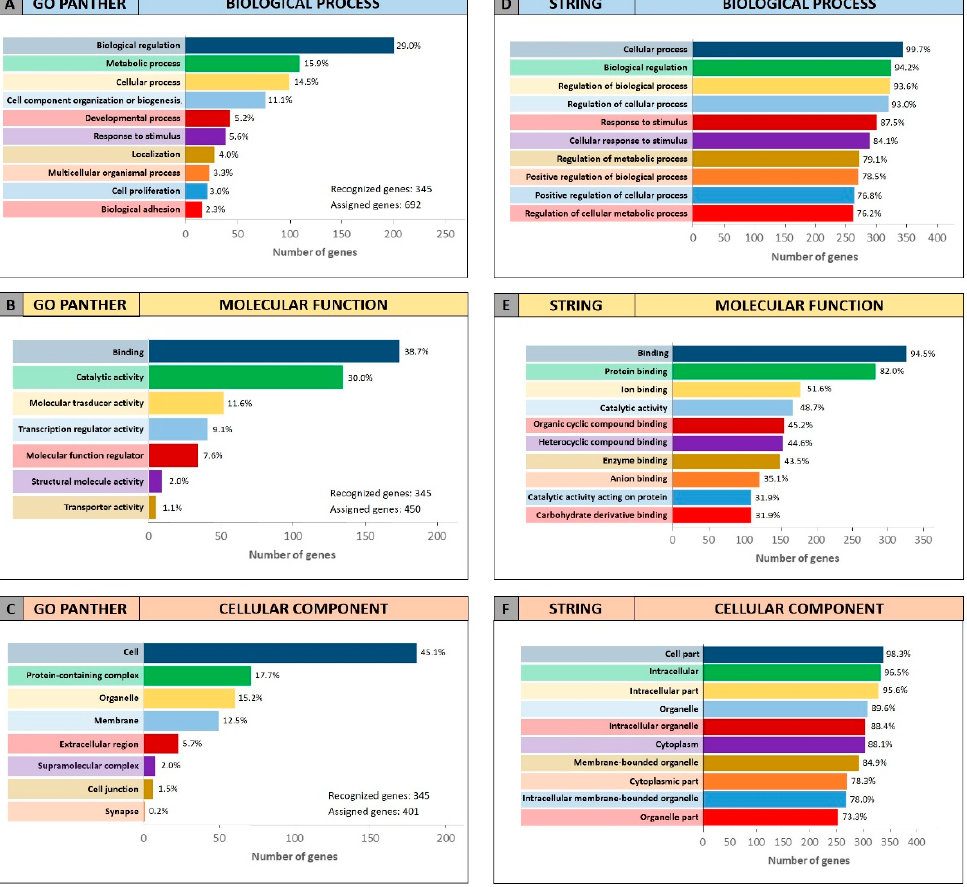
Figure 4. Gene Ontology enrichment of the 345 genes identified through DIANA-mirPath. Panel ( A , D ) GO PANTHER and STRING analyses of the “biological process” category; panel ( B , E ) GO PANTHER and STRING analyses of the “molecular function” category; panel ( C , F ) GO PANTHER and STRING analyses of the “cellular component” category.